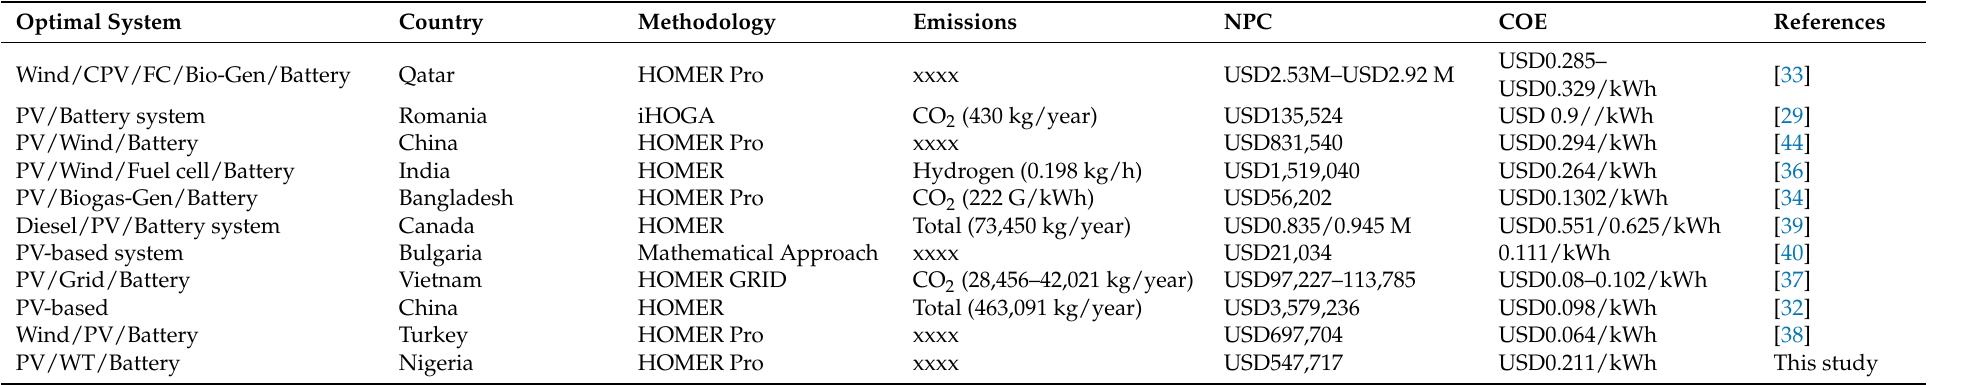
Table 15. Comparison of the proposed EVCS system with other existing